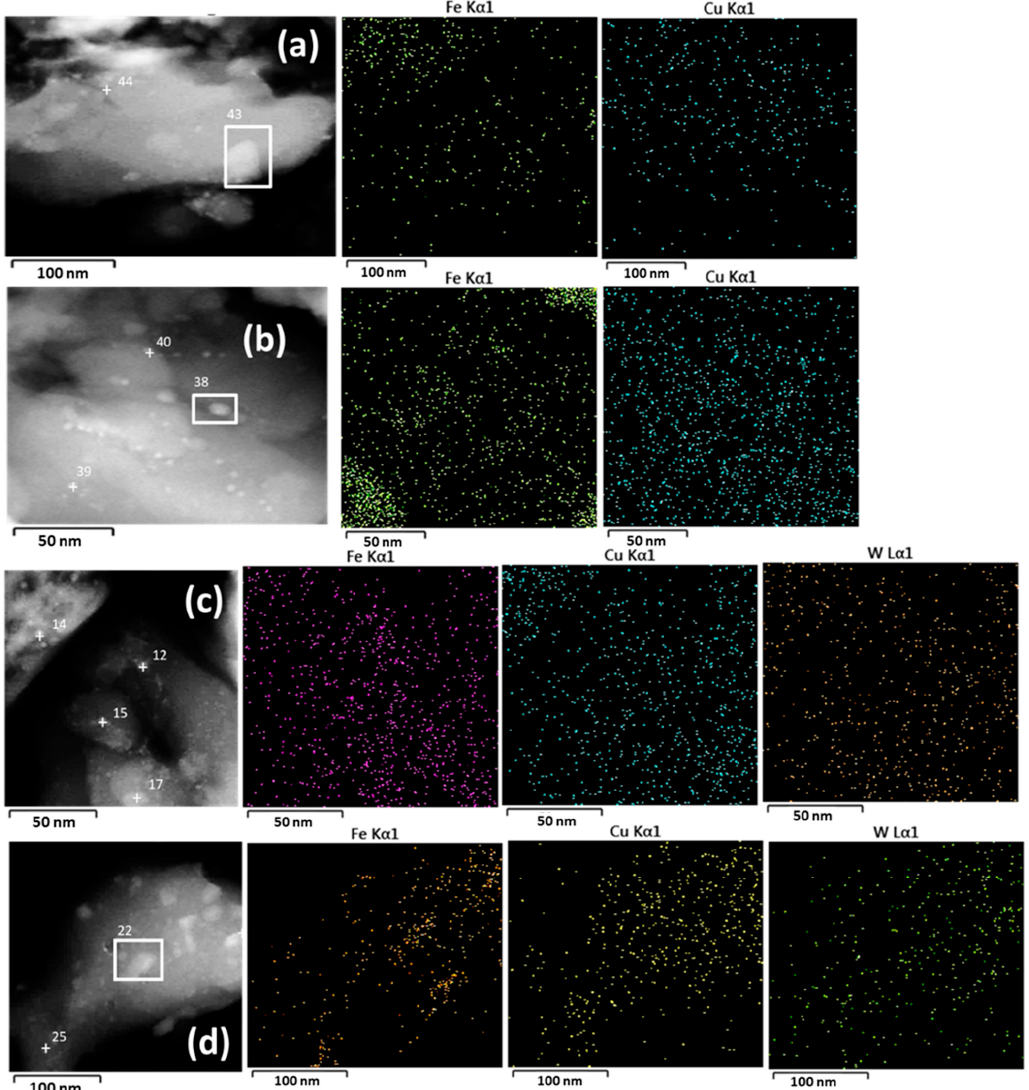
Figure 6. STEM micrographs and EDX mapping images of ( a ) Fe-Cu-Z, ( b ) Fe-Cu-Zag, ( c ) W-Fe-Cu-Z, and ( d ) W-Fe-Cu-Zag catalysts.